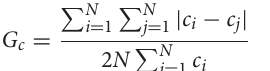
z ( t ) σ decreases. Other possible choices are X = N core , [ k out ]